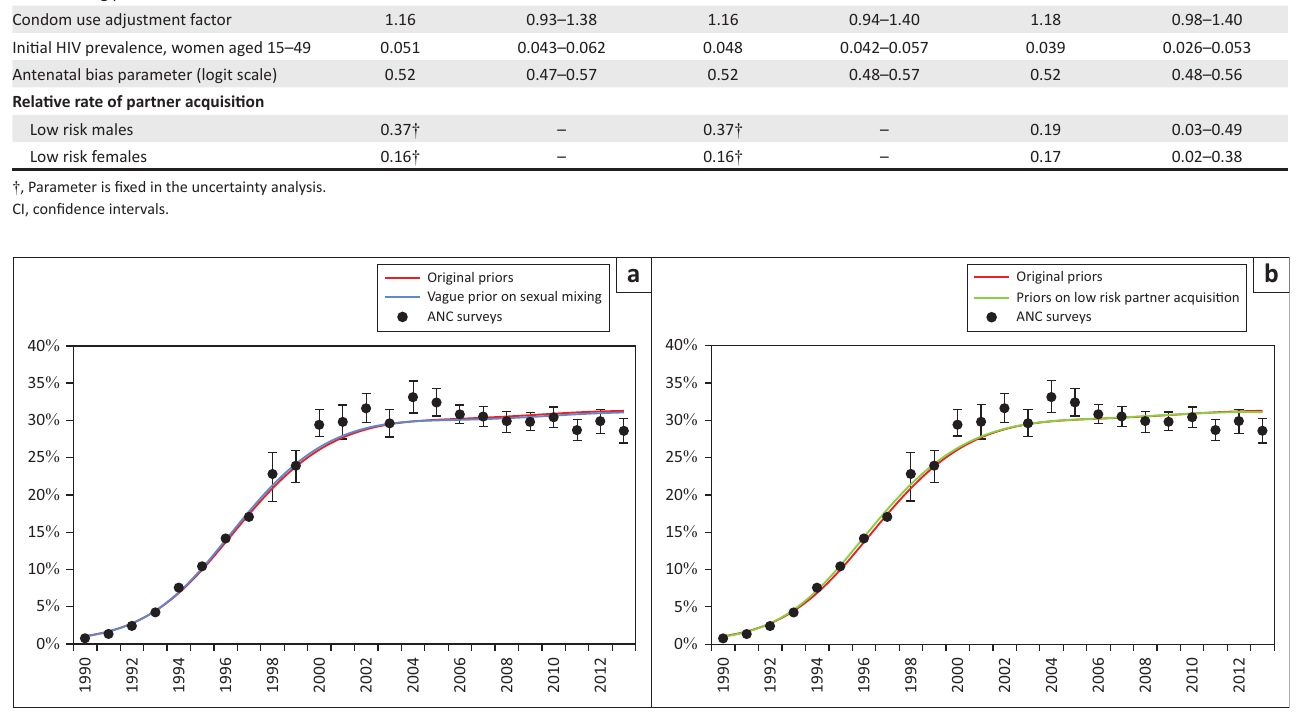
FIGURE 2: Antenatal HIV prevalence in Gauteng: Effect of alternative priors on (a) sexual mixing and (b) low risk